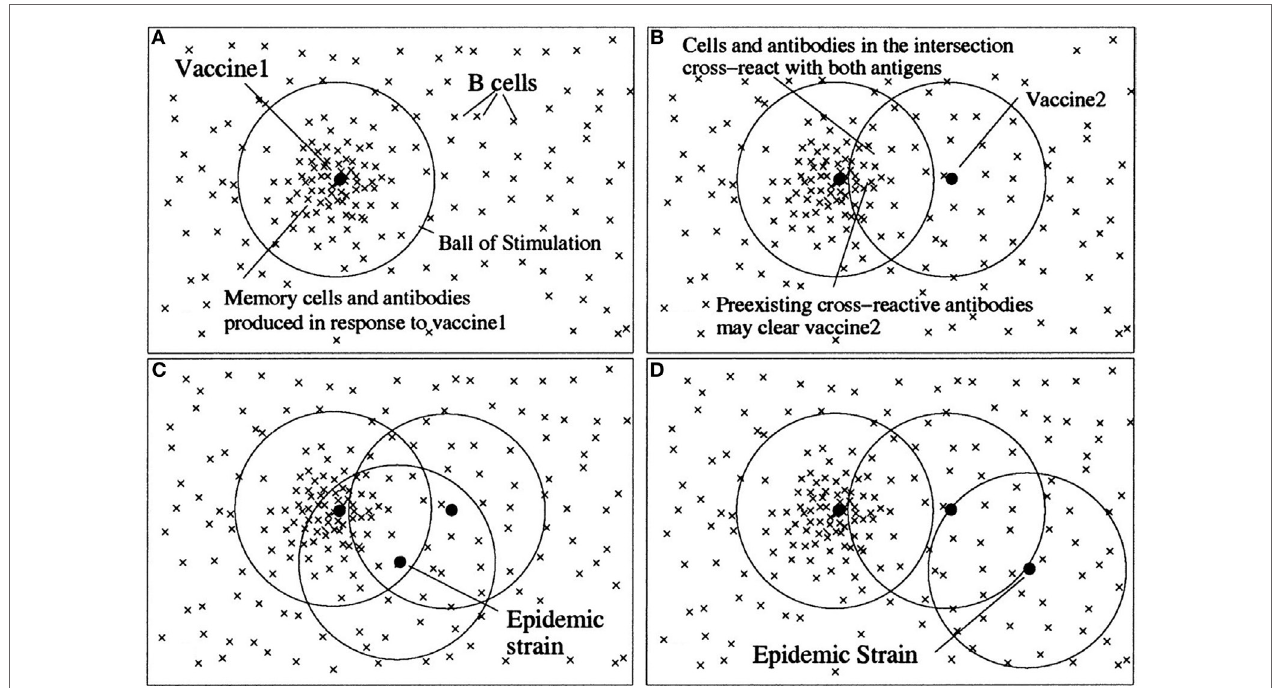
FiGUre 3 | an illustration of the antigenic distance hypothesis . Shape space diagrams are a way to illustrate the affinities between multiple B cells/antibodies and antigens, and also the antigenic distances between antigens. In these shape space diagrams, the affinity between a B cell or antibody ( × ) and an antigen ( • ) is represented by the distance between them. Similarly, the distance between antigens is a measure of how similar they are antigenically. (a) B cells with sufficient affinity to be stimulated by an antigen lie within a ball of stimulation centered on the antigen. Thus, the first vaccine (vaccine 1) creates a population of memory B cells and antibodies within its ball of stimulation. (B) Cross-reactive antigens have intersecting balls of stimulation, and antibodies and B cells in the intersection of their balls – those with affinity for both antigens – are the cross-reactive antibodies and B cells. The antigen in the second vaccine (vaccine 2) will be partially eliminated by preexisting cross-reactive antibodies (depending on the amount of antibody in the intersection), and thus the immune response to vaccine 2 will be reduced. (C) If a subsequent epidemic strain is close to vaccine 1, it will be cleared by preexisting antibodies. (d) However, if there is no intersection between vaccine 1 and the epidemic strain, there will be few preexisting cross-reactive antibodies to clear the epidemic strain quickly, despite two vaccinations. Note, in the absence of vaccine 1, vaccine 2 would have produced a memory population and antibodies that would have been protective against both the epidemic strains in (C) and (d) . For an antigen with multiple epitopes (such as influenza), there would be a ball of stimulation for each epitope (12). Copyright (1999) National Academy of Sciences,